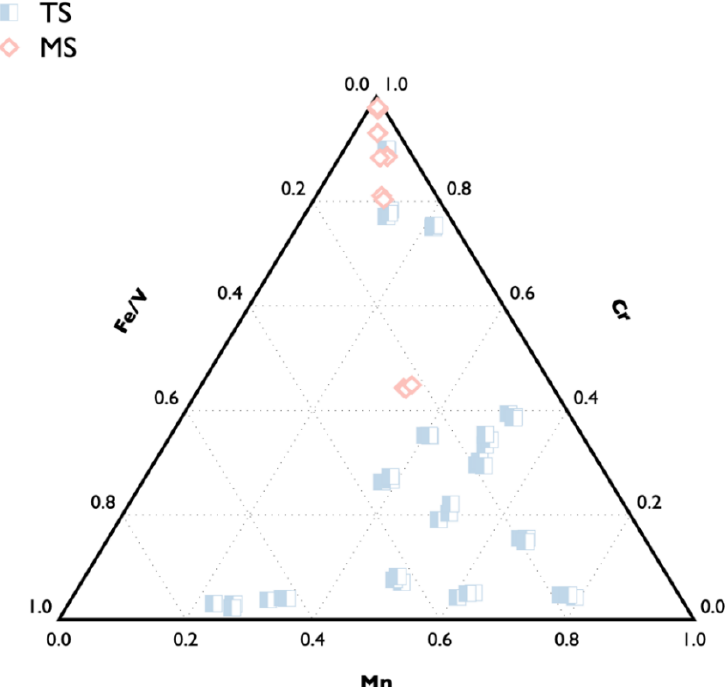
Figure 9. The scatter diagram of Fe vs. Mn reveals that Tanzanian purple spinels can be separated from Myanmar samples.